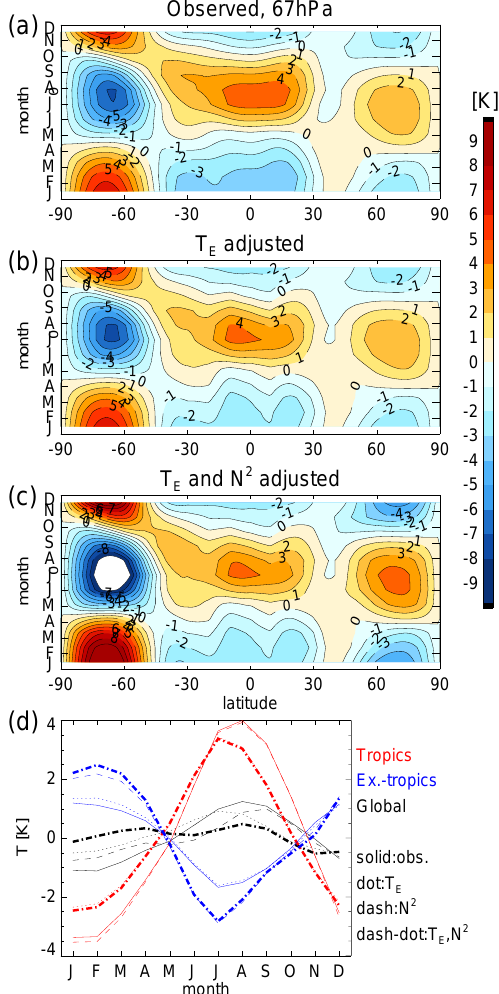
Fig. 6. (a) The annual cycle of area-weighted temperatures at 67 hPa in ERA-Interim (color coded contours, values outside colorbar in white). (b) Ditto for the temperature adjusted by the change in equilibrium temperature in response to ozone variations (eqn. 6). (c) Ditto for the temperature adjusted by the change in equilibrium temperature in response to ozone variations, and latitudinal structure in N 2 (eqn. 5). (d) The annual cycles of area-integrated temperatures (black: global, red: tropics, blue: combined extratropics). The solid lines are for the observed (ERA-Interim) temperatures as shown in (a), the dotted lines for the ozone-related adjustment (eqn. 6, corresponding to panel b), the dashed lines for the N 2 -adjusted temperature (eqn. 7), and the bold dash-dotted lines for the temperature adjusted for both ozone and N 2 (eqn. 5, corresponding to panel c).